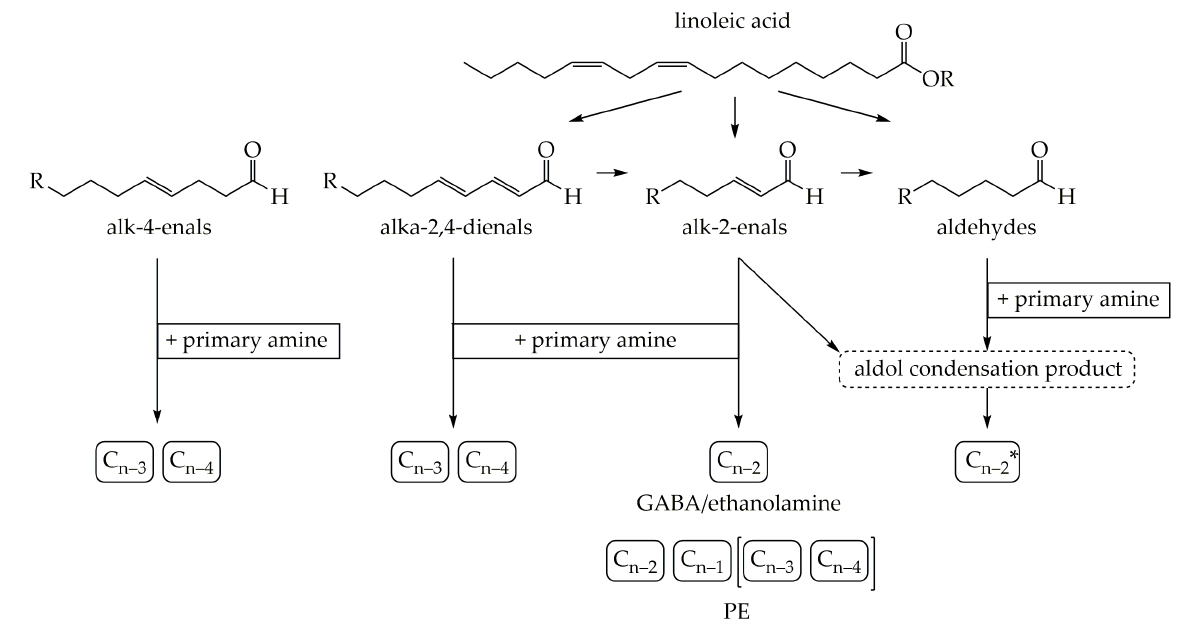
Figure 6. Systematic overview of the formation pathway of methyl ketones from linoleic acid and secondary degradation products; *: refers to the main alkyl chain length of the aldol condensation product; compounds in brackets have only been detected in some experiments.